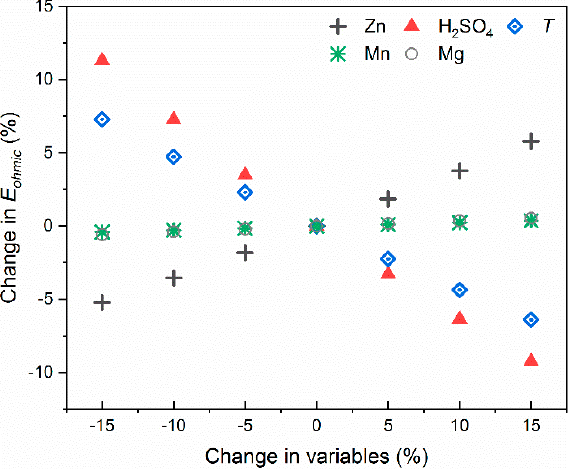
Figure 7. Effect of variable changes on the level of ohmic drop ( E ohmic ) predicted by Aalto-I